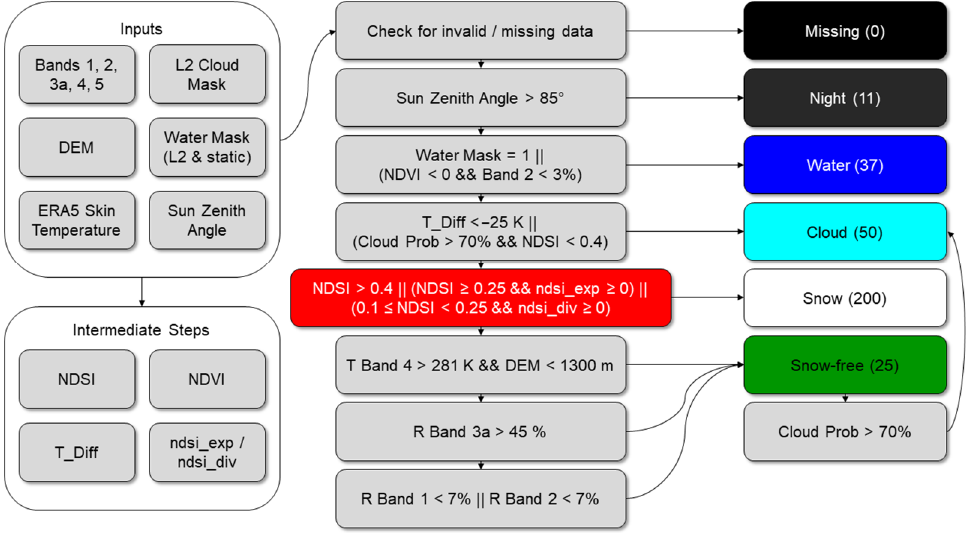
Figure 3. Flowchart of the TIMELINE Snow Mask Processor. The central NDSI -based snow recogni- tion is highlighted with red color.